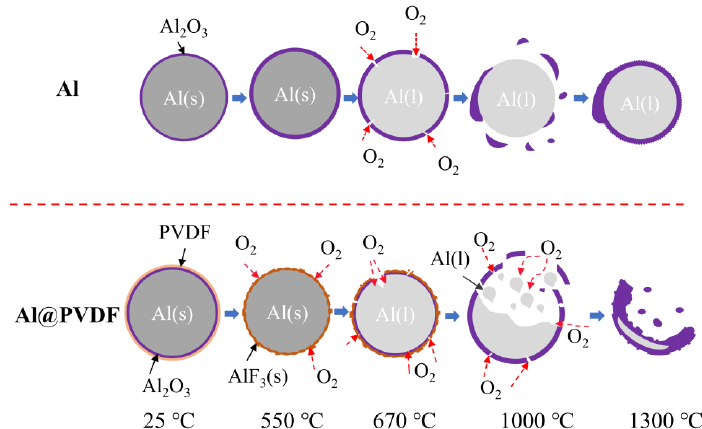
Figure 8. The diagram of the potential oxidation mechanism.